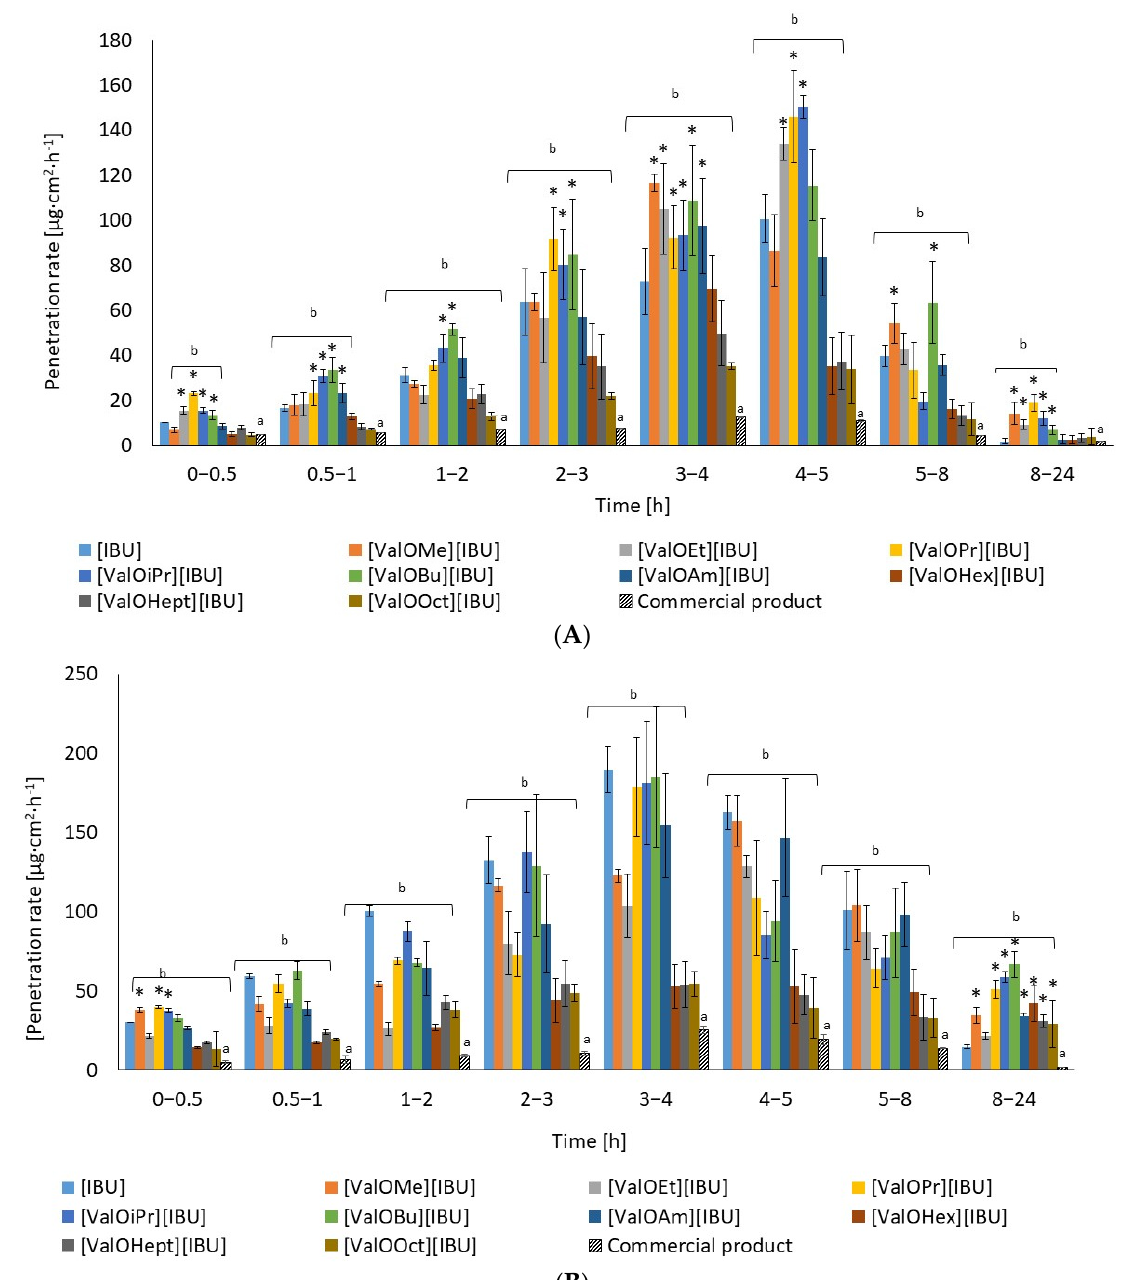
Figure 5. The permeation rate of [IBU] and its modifications and commercial product permeated through human skin ( A ) and Strat-M™ ( B ). All values are presented as mean ± SD where n = 3. * p < 0.001, in compared unmodified [IBU]. Different letters— significant differences between Celugel ® (b) and commercial product (a).